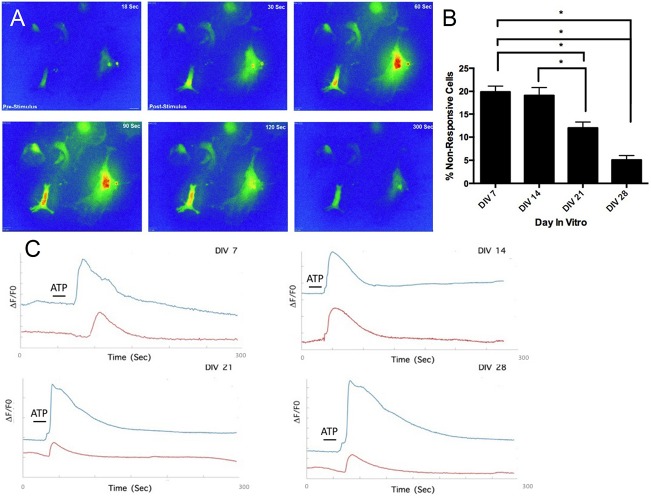
Functional assessment of mESC derived astrocytes. (A) Time-lapse heat-map of activated astrocytes after stimulation (A) via adenosine triphosphate (ATP) (50 μM). (B) Decrease in percentage of non-responsive cells after ATP stimulation, over the course of 4 weeks. (C) DIV 7-DIV 28 astrocytes treated with suramin exhibit stunted Ca2+ responses after ATP application (red traces), compared to untreated astrocytes (blue traces), ∗P < 0.05.